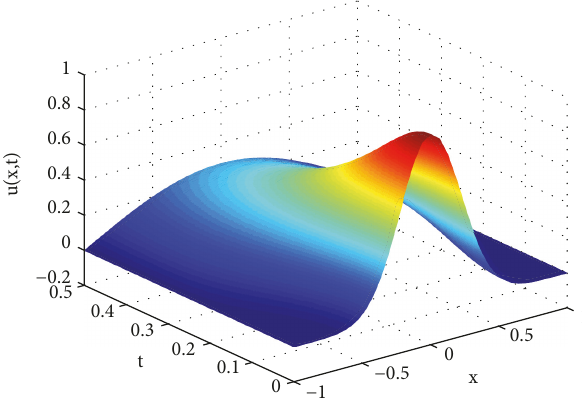
Figure 10: Fractional Brownian motion with 𝛼 = 0.5, 𝛽 = 1